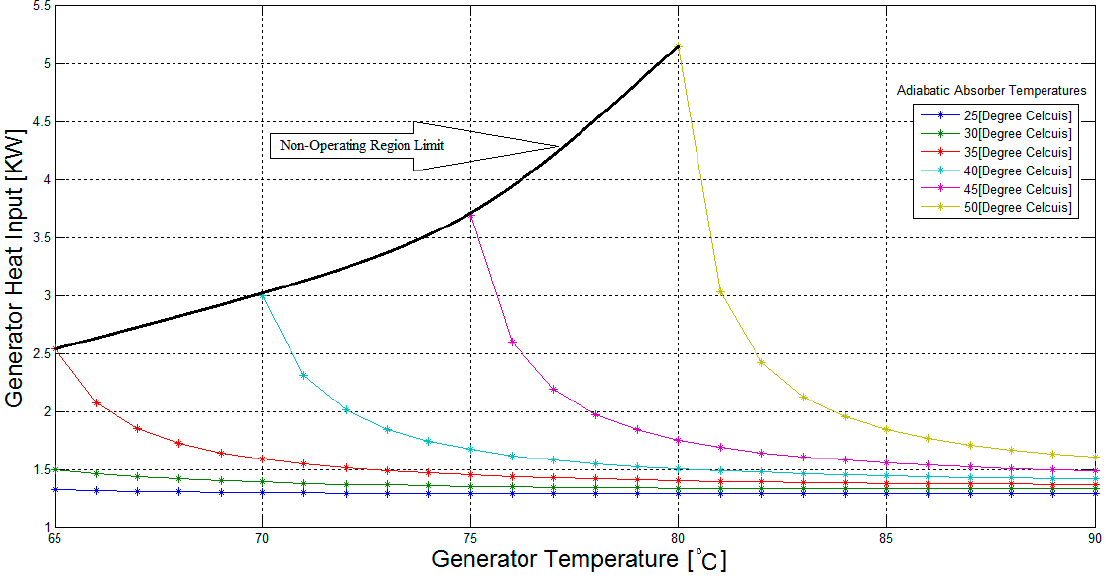
Figure 5. Graph showing the variation of the LiBr mass concentration of the solution entering the adiabatic absorber, with generator and adiabatic absorber temperatures ((cid:1846) (cid:3030)(cid:3042)(cid:3041) = 35 ℃, (cid:1846) (cid:3032)(cid:3049)(cid:3028) = 10 ℃) .